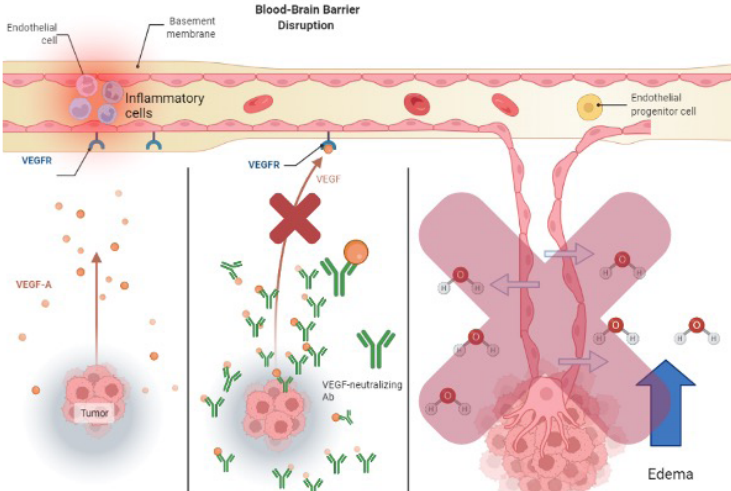
Figure 3. How VEGF neutralizing antibodies act to mediate vasogenic edema. This is distinctly different than steroids increasing tight junction